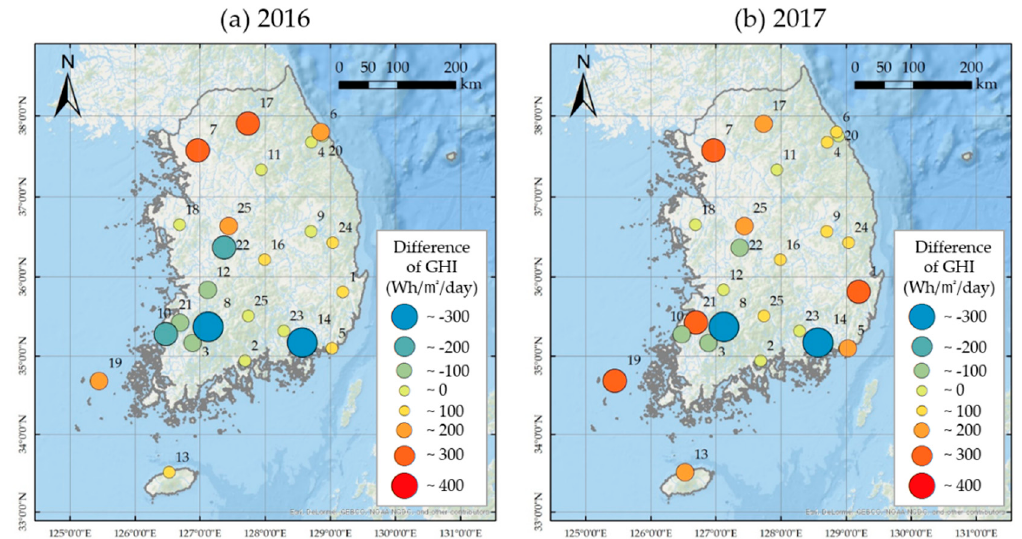
ff erence between satellite-derived and ground-derived annual Figure 14. Difference between satellite-derived and ground-derived annual GHI. Figure 14. Di Figure 14. Difference between satellite-derived and ground-derived annual GHI.